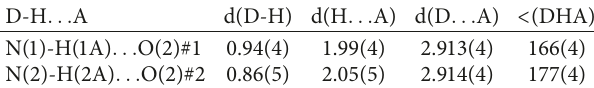
Table 4: Hydrogen bonds for BDSC (˚A and ° ).